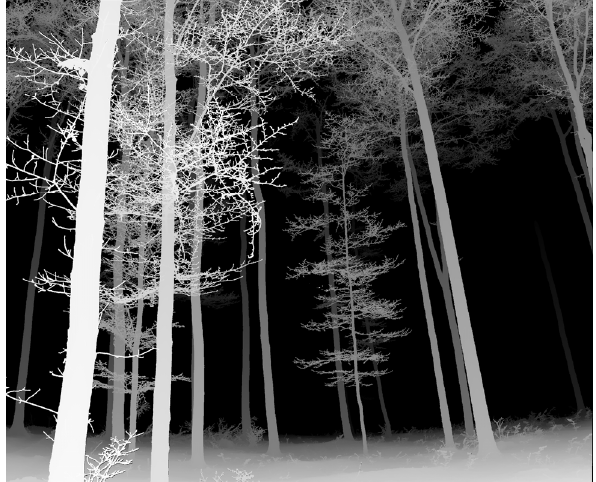
Figure 1. Range image of the beech stand (range between 5.14 m ≤ s ≤ 30.00